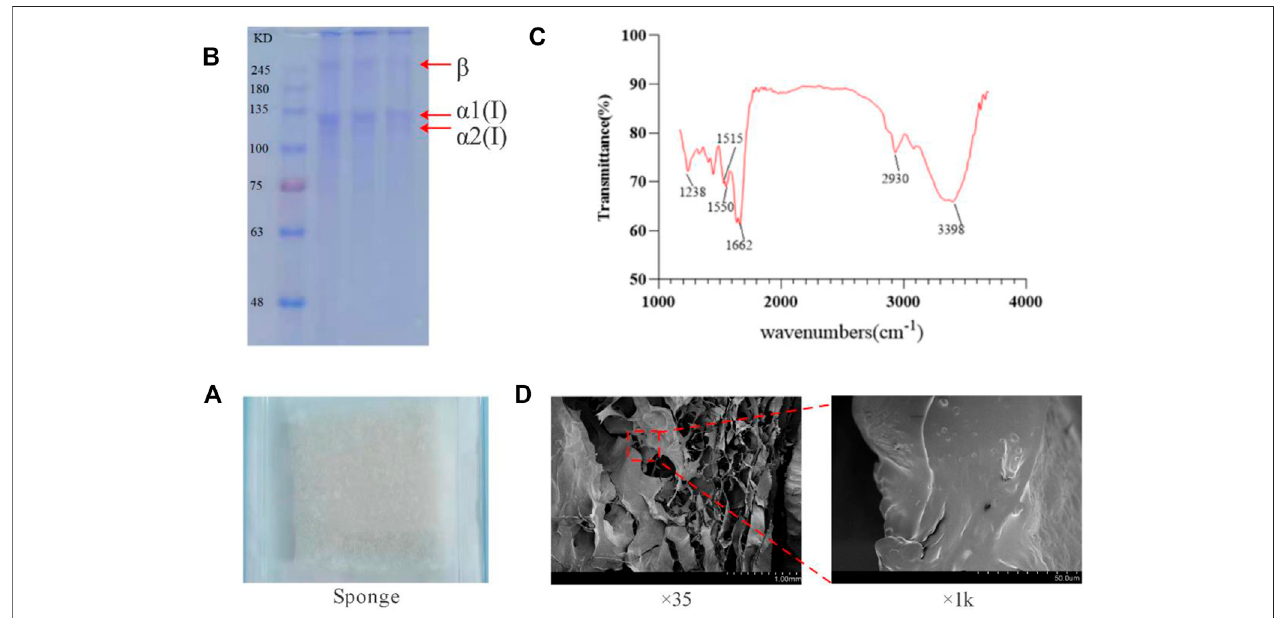
FIGURE 2 | Molecular weight and infrared absorption spectrum of tilapia collogen and sponge microstructure. (A) . Irradiation-sterilized collagen sponge. (B) . Results of SDS-PAGE electrophoresis of collagen. (C) . Infrared absorption spectra of collagen. (D) . Electron microscope scan of collagen